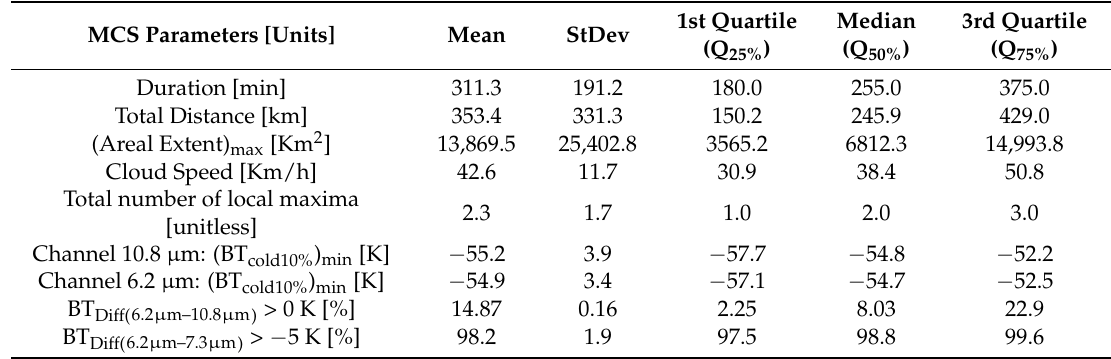
Table 4. Basic descriptive statistics for the number of MCSs with at least one CC localmax event